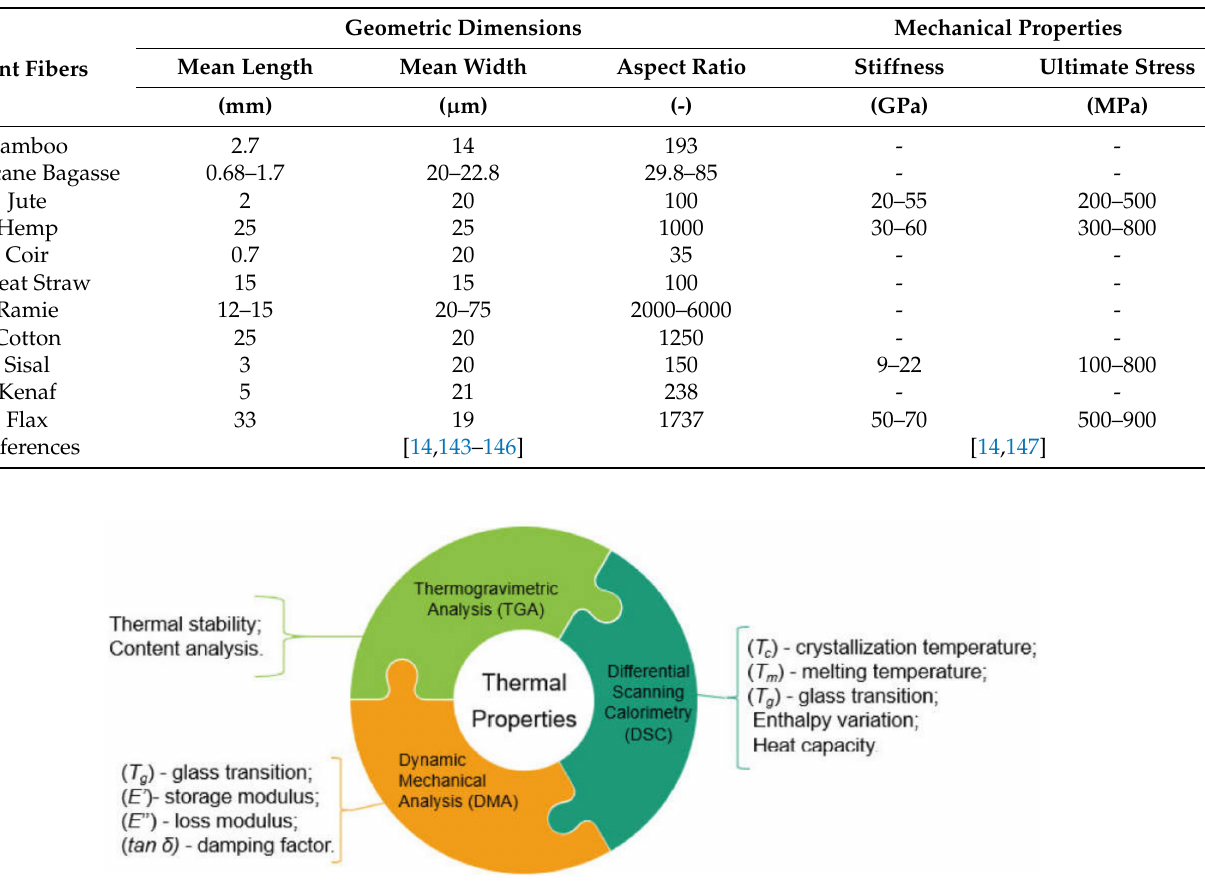
Table 2. Plant fibers’ properties.